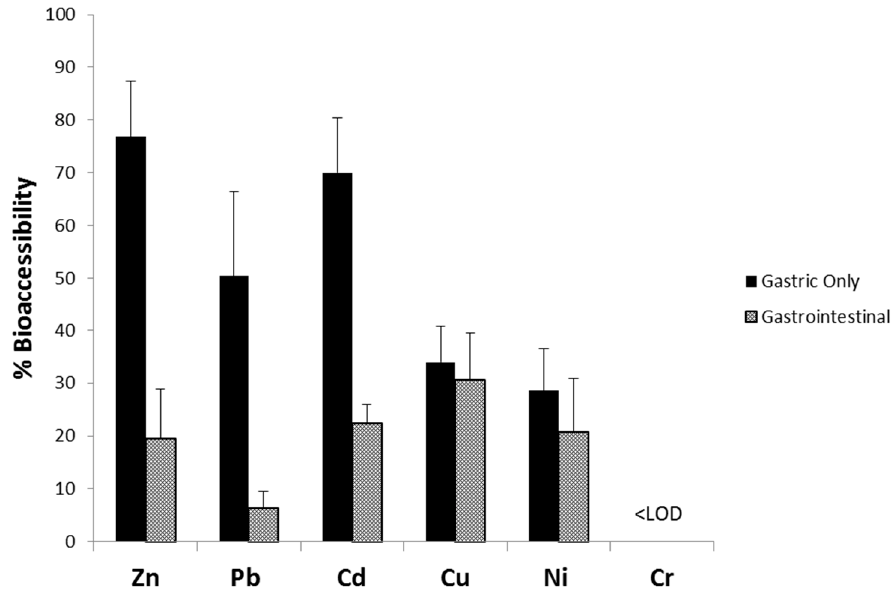
Figure 2. Comparison of median bioaccessibility values from the house dust samples ( n = 33) using the PBET G-alone versus GI method. Error bars show the 75th percentiles.